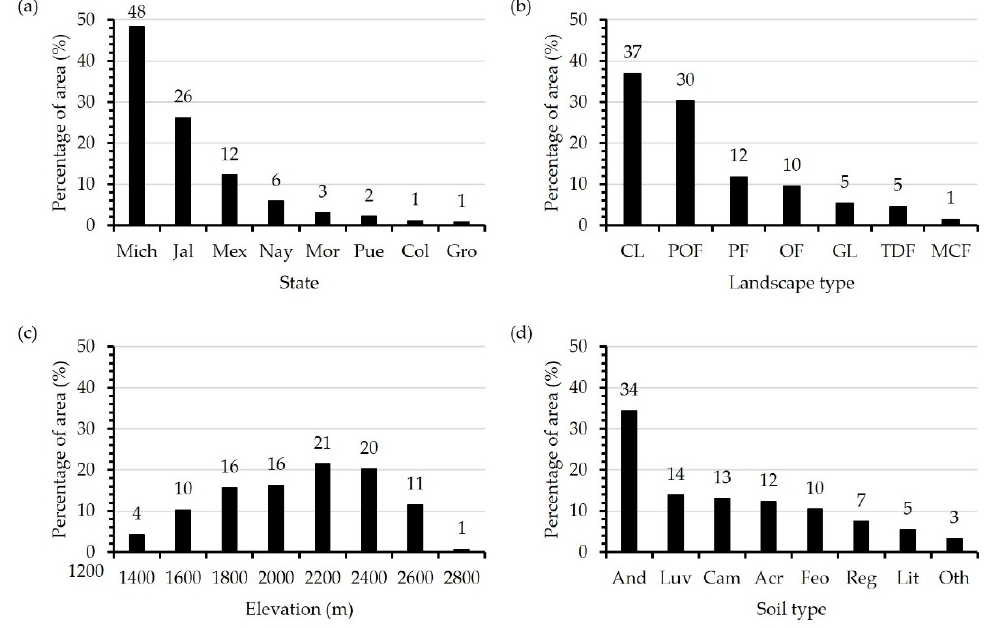
Figure 2. Percentage of suitable areas for the cultivation of Hass avocado according to ( a ) state, ( b ) land cover, ( c ) elevation, and ( d ) soil type. Key of states: Mich: Michoac á n; Jal: